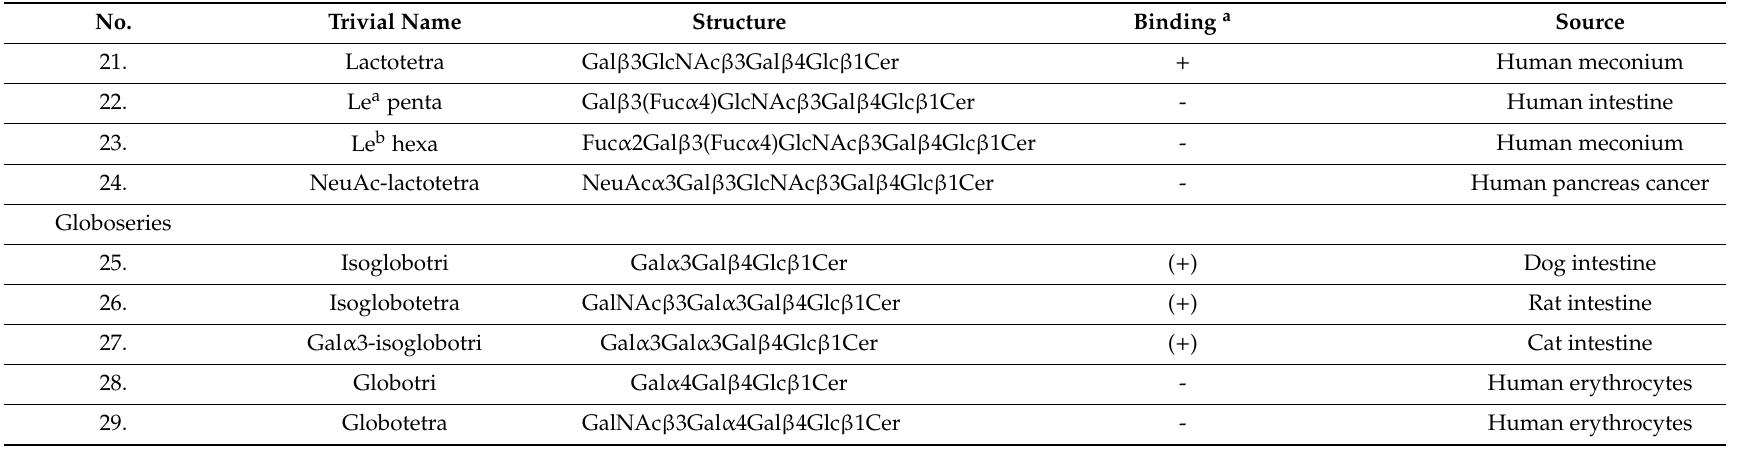
Table 1. Binding of Acinetobacter baumannii to reference glycosphingolipids on thin-layer